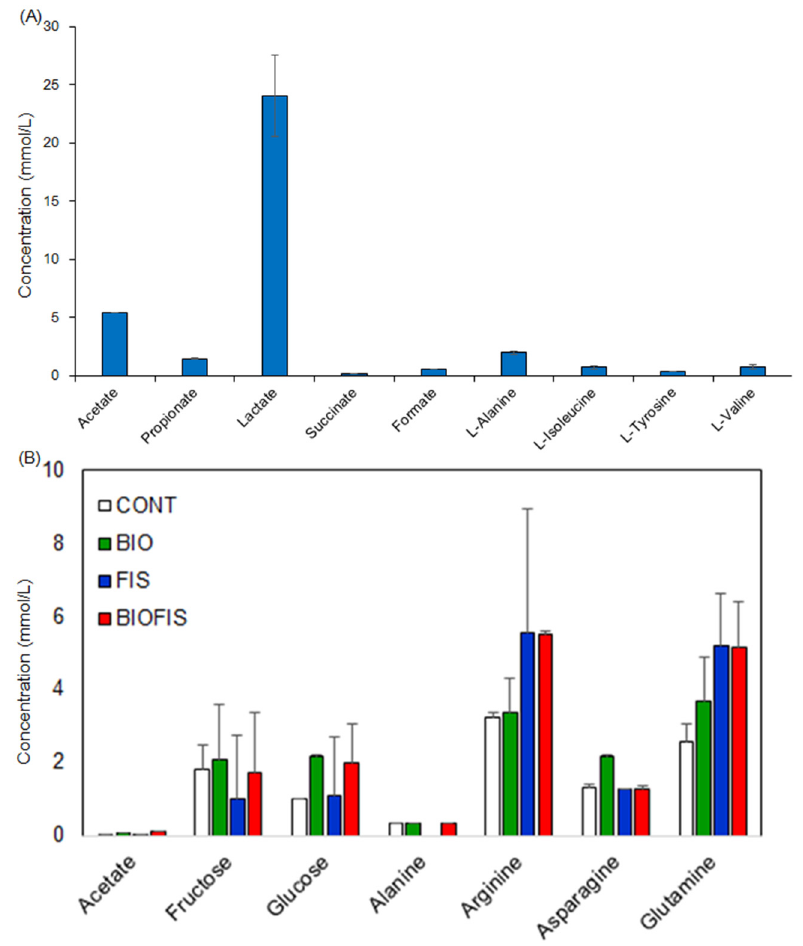
Figure 4. Evaluation of concentration of organic compounds accumulated in soil ( a ) and Komatsuna ( b ). The samples of control, amended soil with biomass, fish, and biomass plus fish were noted as CONT, FIS, BIOFIS, respectively.